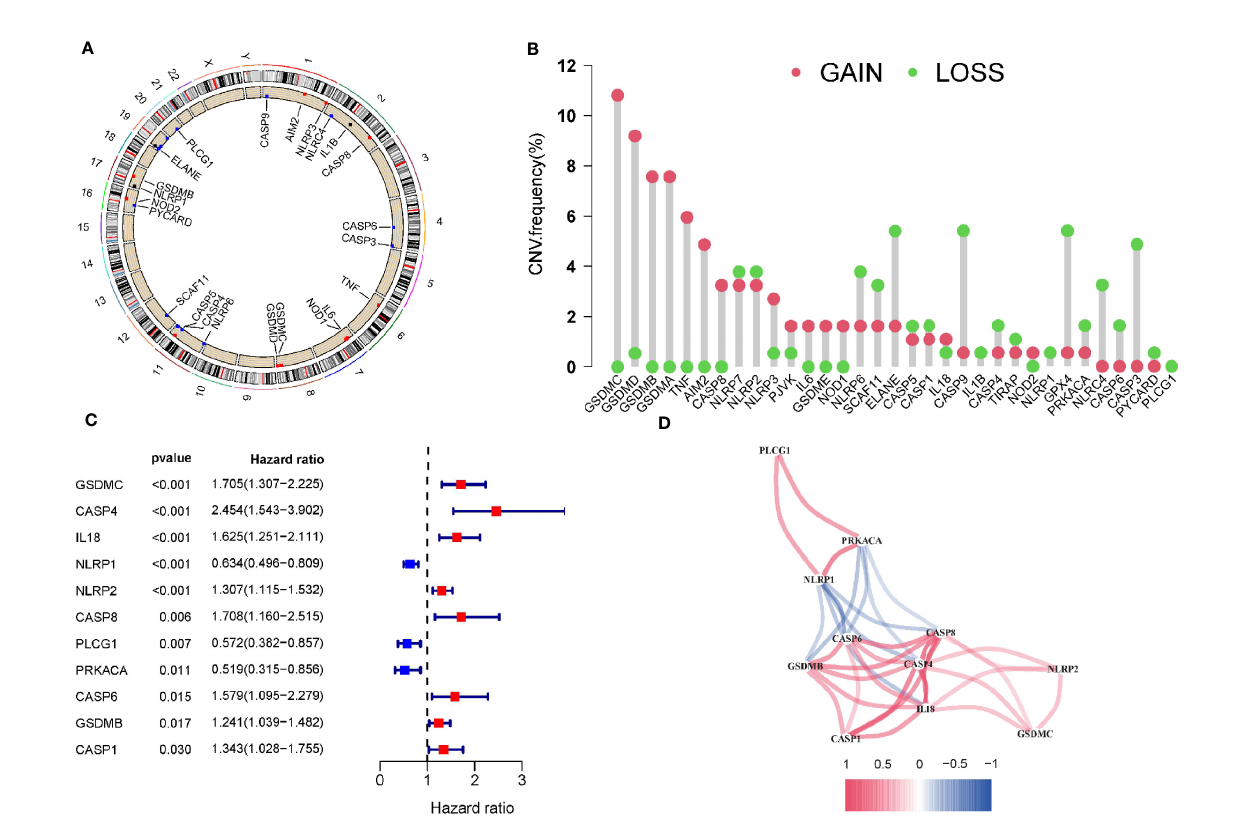
FIGURE 1 | Copy number variations of PRGs in PAAD. (A) The location of CNV change of 33 PRG on chromosomes in the PAAD cohort. (B) The CNV variation frequency of 33 PRG in the PAAD cohort. (C) The univariate Cox regression analysis for PRGs in pancreatic cancer. (D) The correlation network of the pyroptosis- related genes. Red represents a positive correlation, while blue represents a negative correlation. The deeper the color, the stronger the